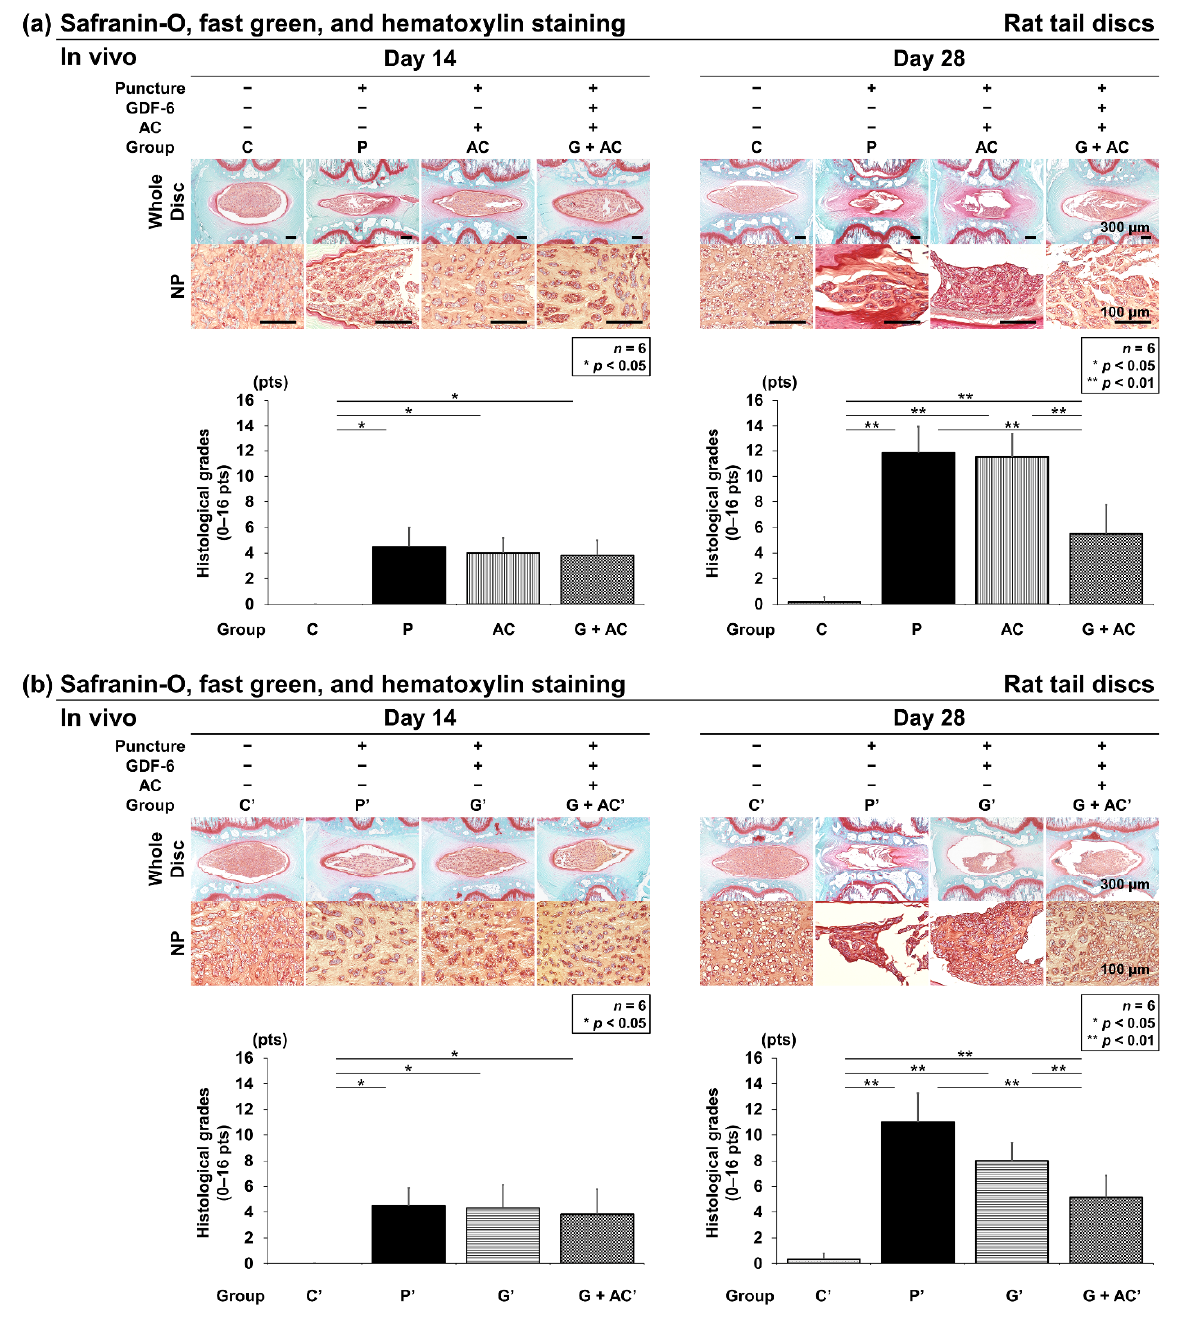
Figure 6. Effects of co-administration of growth differentiation factor-6 (GDF-6) and atelocollagen (AC) on histological intervertebral disc (IVD) degeneration in a rat tail puncture model. After establishment of the IVD degeneration model, ( a ) either vehicle (phosphate-buffered saline [PBS]; 2 µ L per disc, group P), AC (2- µ L AC per disc, group AC), or GDF-6 (20 µ g in 2- µ L AC gel per disc, group G + AC) or ( b ) vehicle (PBS; 2 μL per disc, group P’), GDF-6 (20 μg in 2-μL PBS per disc, group G’), or GDF-6 (20 μg in 2-μL AC gel per disc, group G + AC’) was randomly injected. The IVD degeneration was assessed by Safranin-O and fast green staining of the IVDs at 14 and 28 days after injection in low-power fields (×100). We designated the control without puncture (groups C and C’), and compared the four groups (C, P, A, G + AC) and (C’, P’, G’, G + AC’). Data are the mean ± standard deviation ( n = 6). One-way analysis of variance with the Tukey–Kramer post-hoc test was used. Significant differences are set as * p < 0.050 and ** p < 0.010.